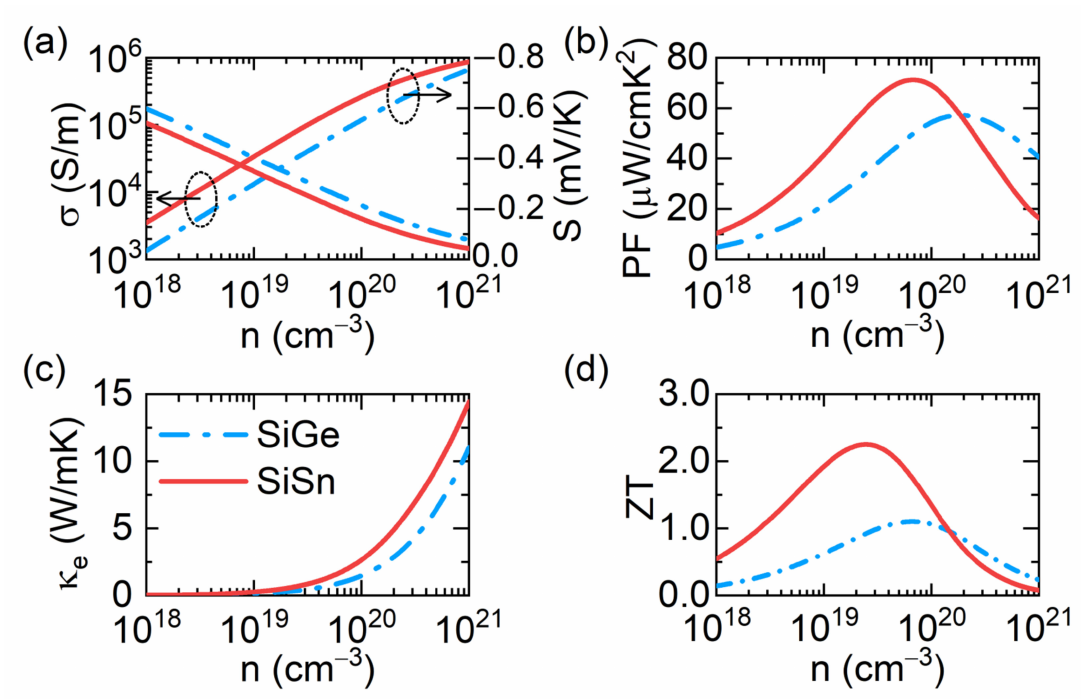
Figure 4. The electrical conductivity σ ( a ), Seebeck coefficient S ( a ), PF ( b ), electronic thermal conductivity κ e ( c ), and ZT ( d ) of n-type SiGe and SiSn at 800